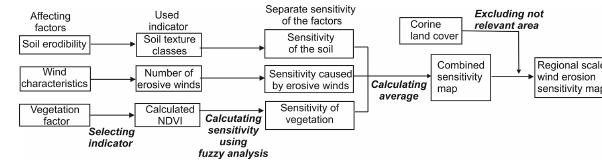
Figure 3. Overview of the applied methodological framework.